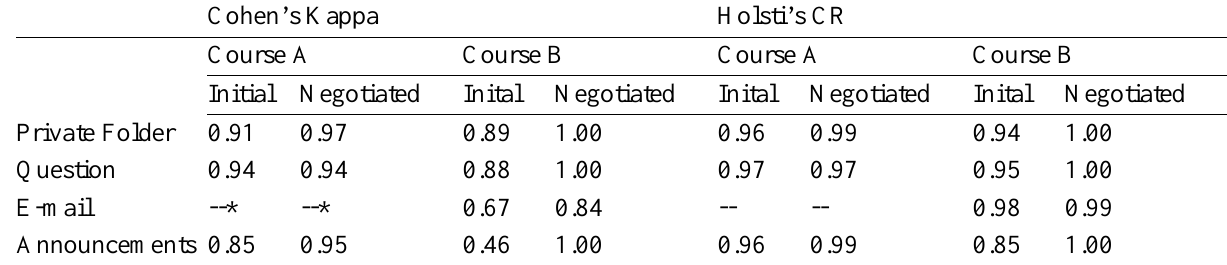
Inter-rater Reliability for Artifact Coding